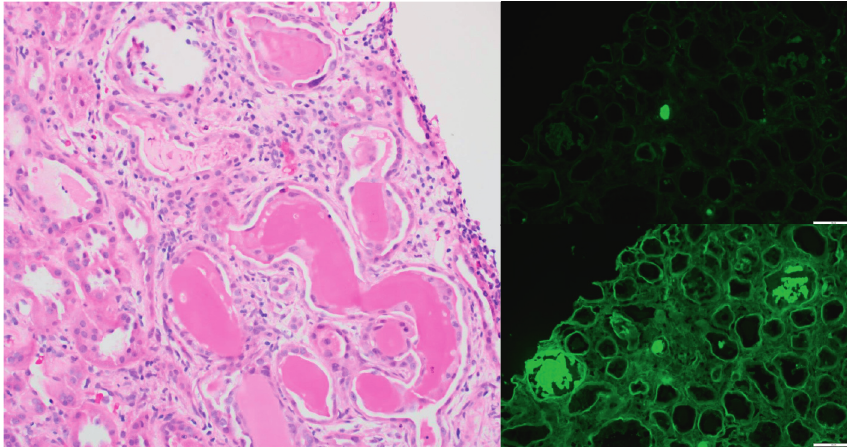
Figure 2: H&E stain of renal biopsy revealing atypical glassy eosinophilic casts associated with cellular reaction in acutely injured tubules (a). Immunofluorescence on renal biopsy is negative for kappa free light chains (b) but shows 2–3+ staining in the atypical casts for lambda free light chains (c).